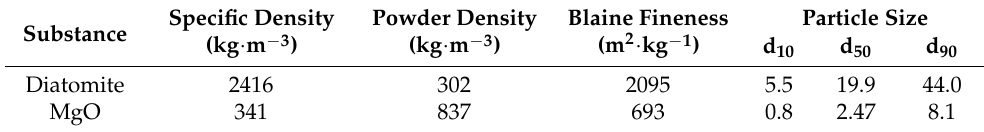
Table 2. Basic physical characteristics of diatomite and